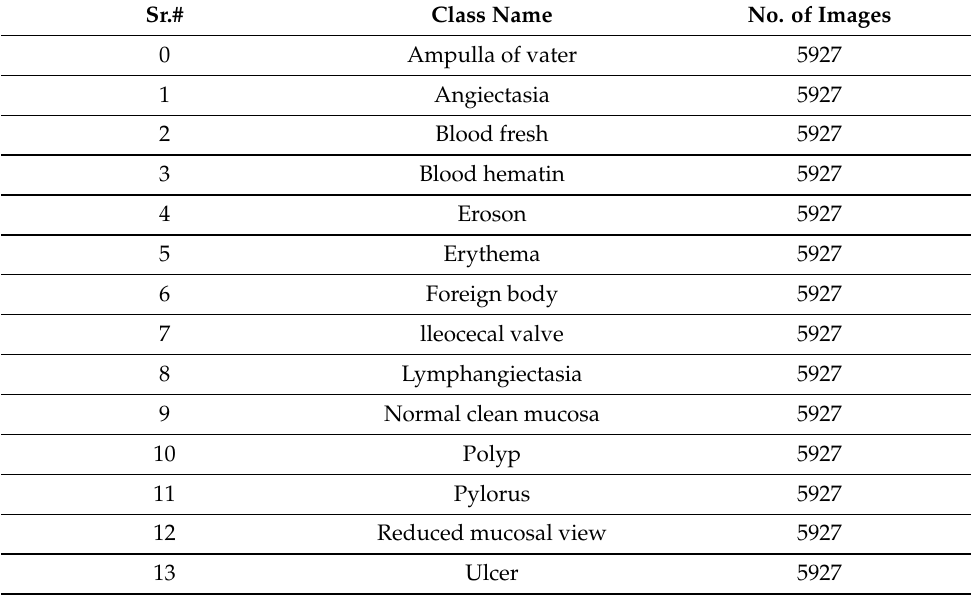
Table 3. Distribution of image samples in WCE dataset after up-sampling.